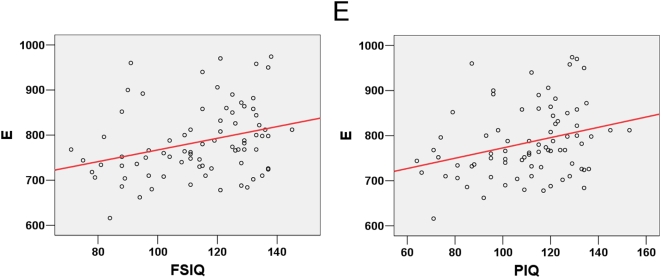
Significant partial correlation between the total number of edges and intelligence tests scores.
 was found to be positively correlated to FSIQ and PIQ.